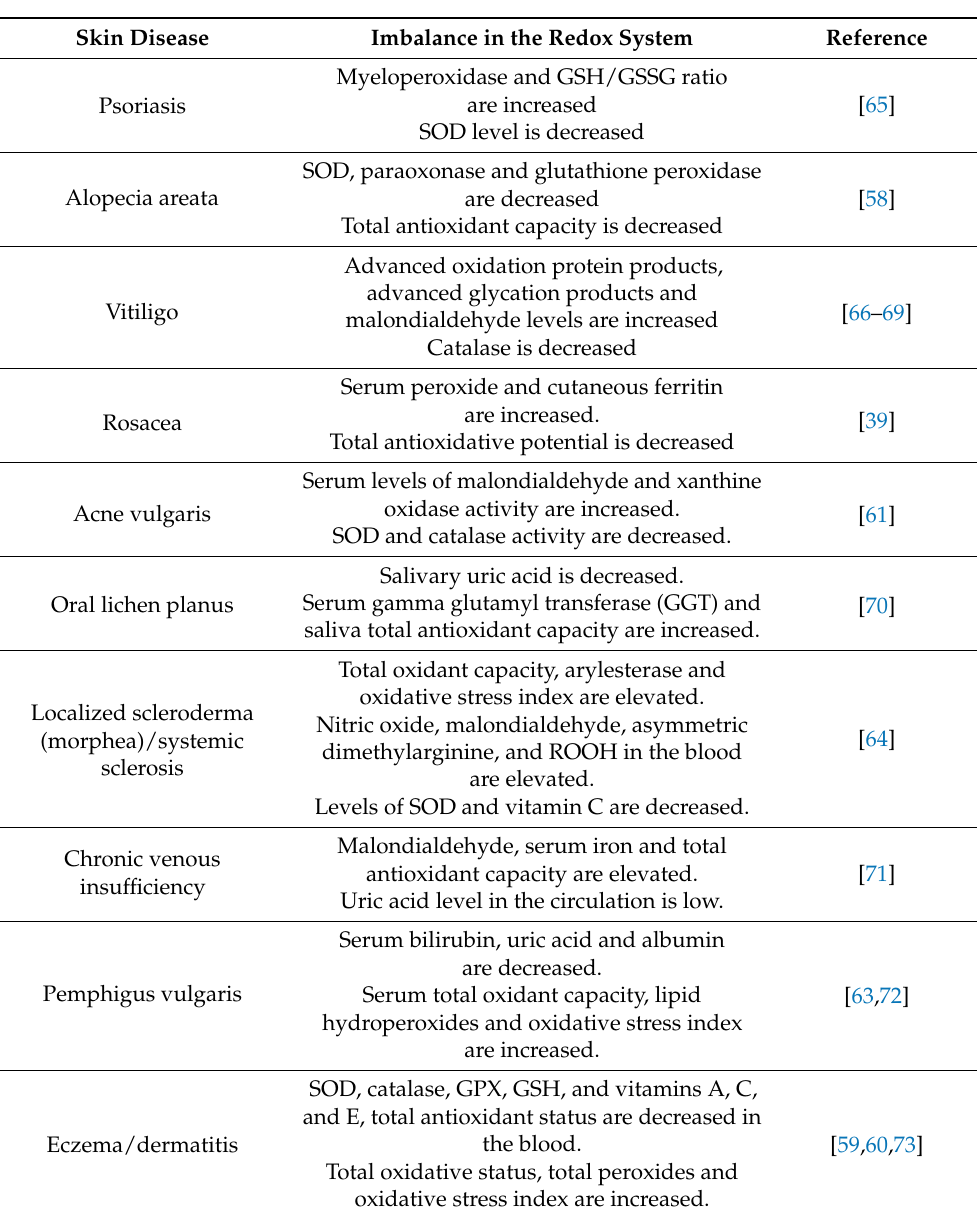
Table 1. Imbalance in the redox system of cutaneous